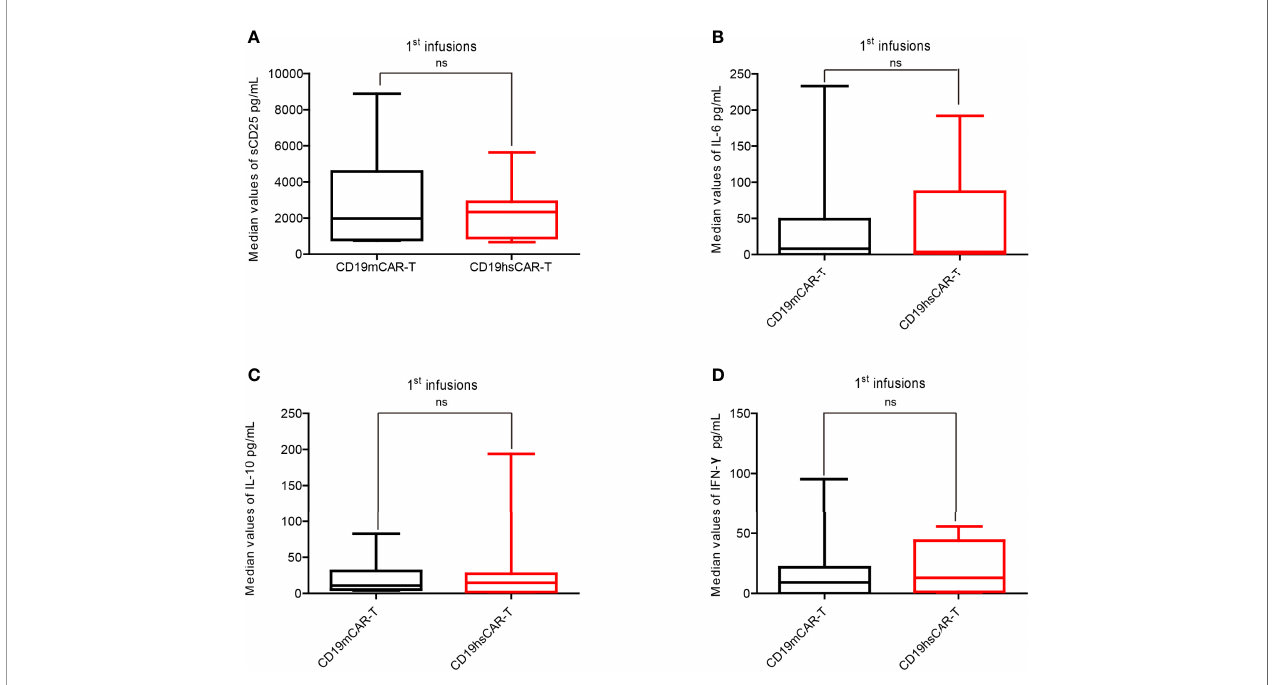
FIGURE 3 | Levels of cytokines in patient sera after the 1 st infusion of CD19m CAR-T and the 1 st infusion of CD19hs CAR-T. (A – D) Comparisons of the median concentration of sCD25 (A) , IL-6 (B) , IL-10 (C) and IFN- g (D) , respectively (n=8). The bars represented the range of concentrations for each cytokines within 30 days after the 1 st infusion; medians are shown as straight lines in each bar. P values were determined by T-test, and the signi fi cant levels were identi fi ed as p<= 0.05. Levels of each cytokine were repeatedly tested 7 times within 30 days after infusion. ns, Not statistically signi fi cant.